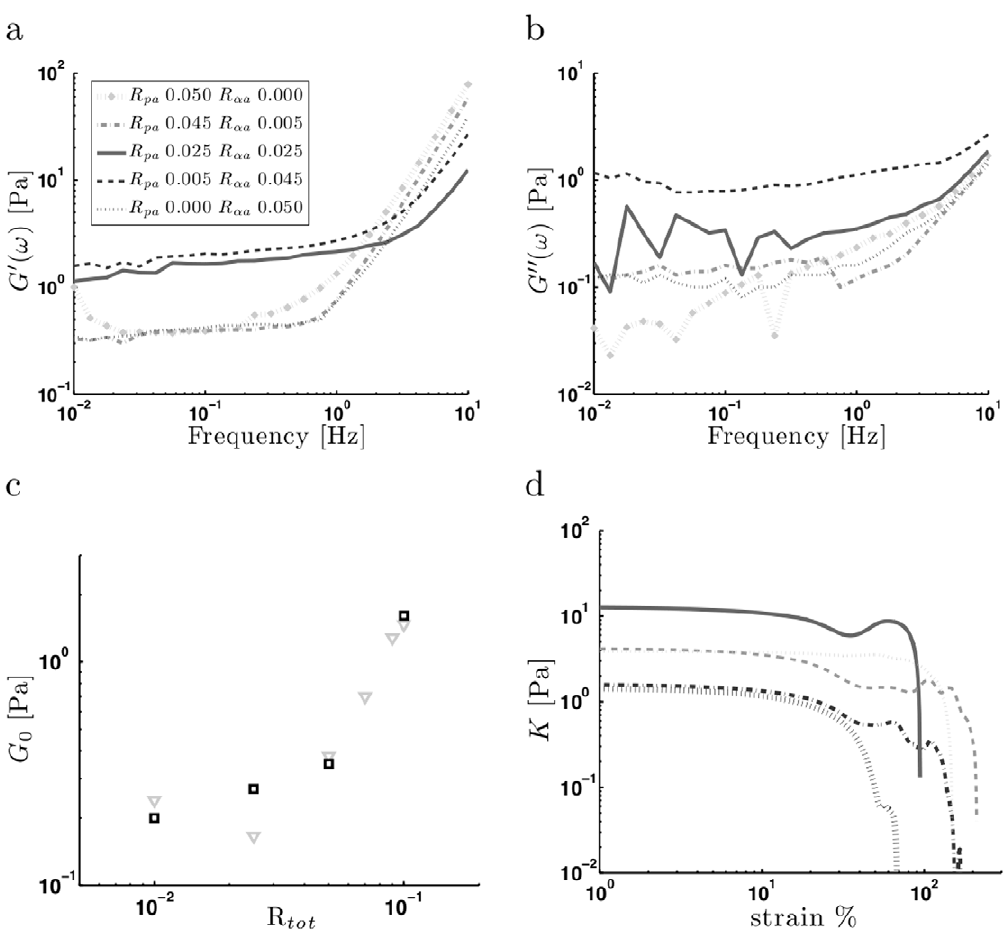
Figure 5. Viscoelastic properties of composite actin networks. (a) Storage moduli ( G ’ ), (b) loss moduli ( G ’’ ) of actin networks ( c a ~ 10 m M ) with varying concentrations of palladin and a -actinin, R tot ~ : 05 . Composite networks with equal amounts of palladin and a -actinin are slightly stiffer than the others. (Same legend for a–b). (c) Plateau modulus, G 0 of pure palladin (gray triangles) and pure a -actinin (black squares) networks showing correlation between the total amount of crosslinker and stiffness, G 0 . (d) Differential modulus of composite networks in